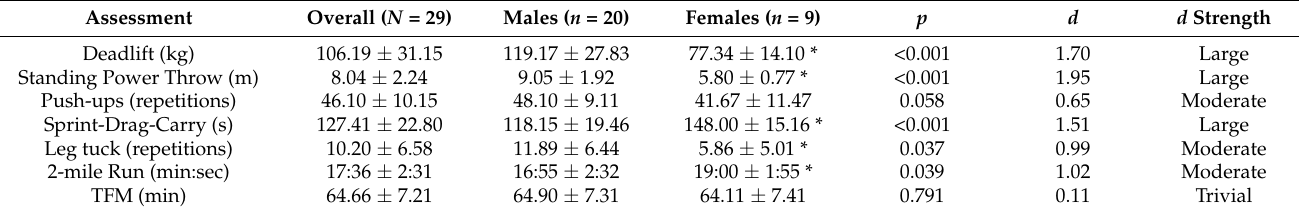
Table 1. Descriptive data (mean ± SD) for the Army Combat Fitness Test event (3-repetition maximum deadlift (deadlift), standing power throw, hand-release push-ups (push-ups), sprint-drag-carry, leg tuck, 2-mile run) raw scores and tactical foot march score for the overall group, males, and females.